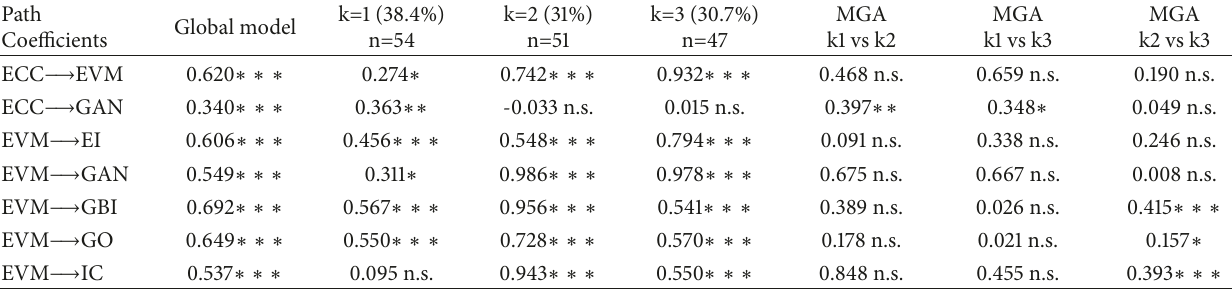
Table 8: Path coefficients for the general model and for the three